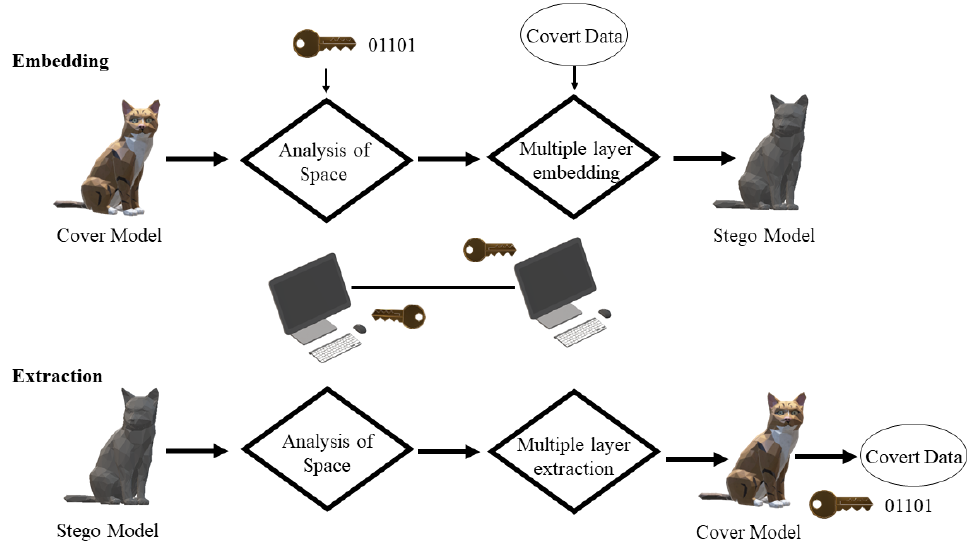
Figure 6. Embedding and extracting procedures